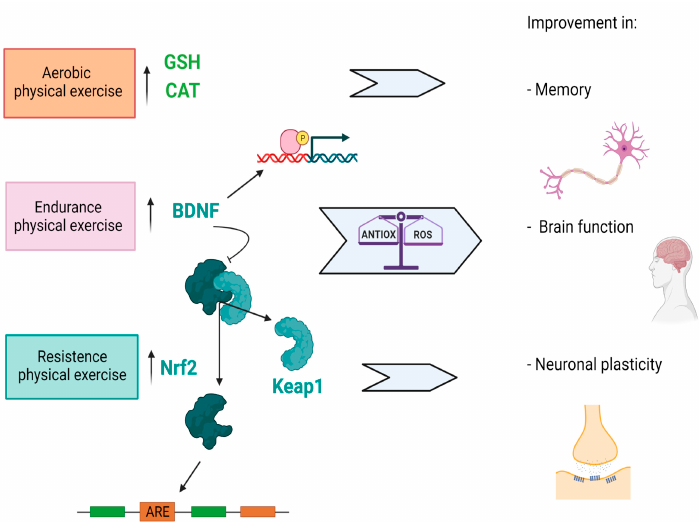
Figure 1. A representation of physical activity effects on brain functioning. Notes : The figure shows how aerobic, endurance and resistance physical exercise promote an upregulation of endogenous antioxidants, such as glutathione peroxidase (GHS), superoxide dismutase and catalase (CAT) and increases Brain-derived Neurotrophic Factor (BDNF) levels. This is responsible for the activation of nuclear factor erythroid 2-related factor 2 (Nrf2) which, once separated from Keap1, translocates into the nucleus and triggers promoter sequences called ‘ARE’. Such a process leads to a balance between the cellular antioxidant defences and the formation of free radicals (ROS) in order to obtain an improvement of cerebral performance and of synaptic neuroplasticity.